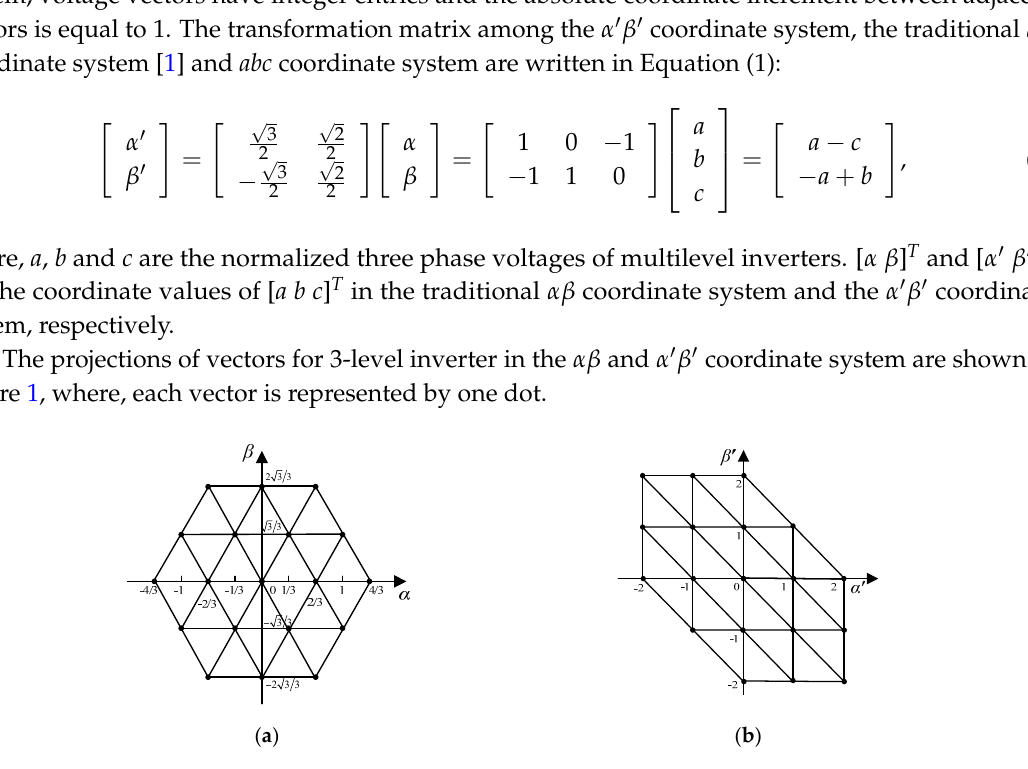
Figure 1. Space vector diagram for 3-level inverter in different coordinate systems, ( a ) in the traditional αβ coordinate system ( b ) in the α′β′ coordinate system.